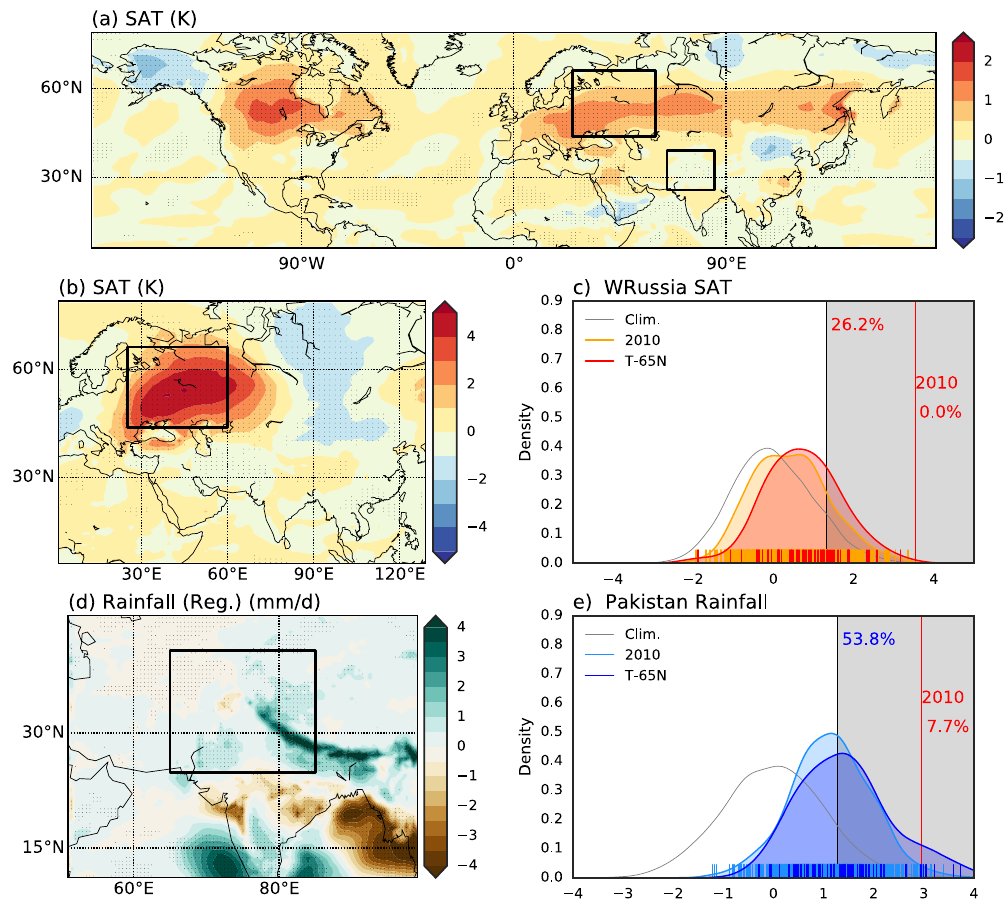
Fig. 6 W@H High-latitude land warming. Panel a : composites of SAT for ensemble members for Glob2010 | T65N (exceeding the 90th percentile, 65 ensemble members out of 649) showing high-latitude land warming. Panel b : composites of SAT for Glob2010 | T65N (exceeding the 90th percentile) and also exceeding the 90th WRussia SAT index (GlobClim) percentile (black solid line in panel c ). Panel c : PDF of WRussia SAT index for Glob2010 (orange solid line), for Glob2010 | T65N (red solid line), and for GlobClim (gray solid line). The rug shows the exact position of the data, which are smoothened in the PDF using a Gaussian kernel to produce continuous density estimates. Panel d : composites of Rainfall for Reg2010 | T65N (exceeding the 90th percentile) and also exceeding the 90th Pakistan Rainfall (RegClim) percentile (black solid line in Panel e ). Panel e : PDF for Pakistan Rainfall index in Reg2010 (solid light blue line), for Reg2010 | T65N (blue solid line) and for RegClim (gray solid line). Both in panels c and e vertical solid black lines show the 90th percentile calculated from the climatological PDF and vertical solid red lines show the 2010 threshold (expressed in units of s.d.), together with the percentage of events that exceed this threshold in the T-65N sub-selection. Anomalies are calculated based on the Glob2010 (or Reg2010 for Rainfall) ensemble mean to differentiate from the impact of 2010 global SST. The stippling represents signi fi cant grid points at α = 0.05 and is calculated applying a Student- t test.